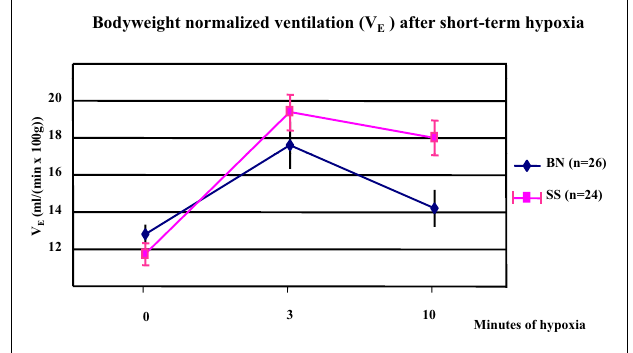
FIGURE 2 |Alteration of bodyweight normalized minute ventilation ( V E ) under short-term hypoxia treatment in SS and BN parental strains. In both strains, V E was significantly increased after 3min of hypoxia ( p < 0.001).This increment was greater in SS than in BN ( p < 0.038). After 10min of hypoxia, BN rats showed greater hypoxic ventilatory roll-off than in SS rats ( p < 0.012).